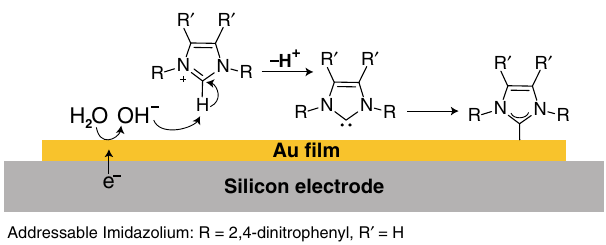
Fig. 2 Suggested mechanism for EC deposition of imidazolium on Au fi lm. EC deposition mechanism for 1,3- bis (2,4-dinitrophenyl)-imidazolium and dimethyl-benzimidazolium on Au-coated Si